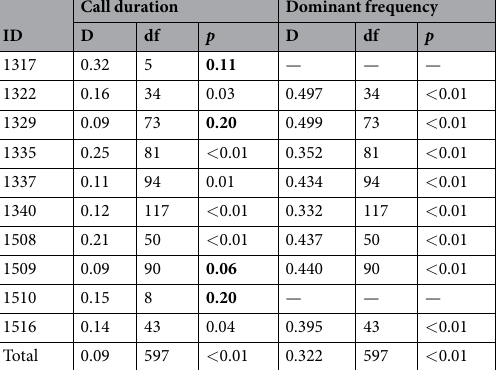
Table 2. Kolmogorov-Smirnov test of call duration and dominant frequency of calling individuals. Normal distributions in each individual are denoted in bold. In two individuals (1317 and 1516) certain frequency values were repeated so it prevented to produce statistical results for testing dominant